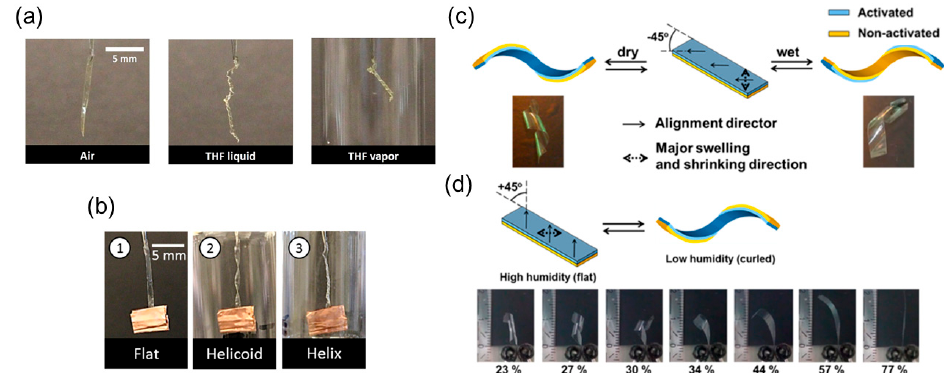
Figure 8. Formation of a helical shape triggered by other stimuli. ( a ) TNE ribbon in air, THF liquid, and THF vapor; ( b ) TNE ribbon remaining flat in air and curling into a helicoid and a self-contacting helix in THF vapor as a function of time; ( c ) A bilayer LCN ribbon, in which the director is 45° to the long axis of the ribbon, showing left-handedness when dried and right-handedness when wet; ( d ) A bilayer LCN ribbon, in which the director is − 45° to the long axis of the ribbon, exhibiting a smooth transition in shape from flat to curled as humidity decreases. Figures ( a , b ) reprinted from [40] with permission from Elsevier; ( c , d ) from [41], with permission from the American Chemical